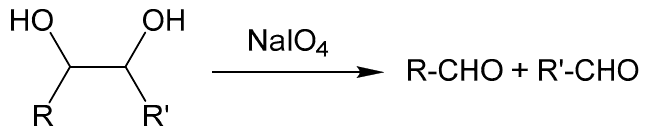
Figure 2. Periodate-mediated oxidation inducing the cleavage of vicinal diols.